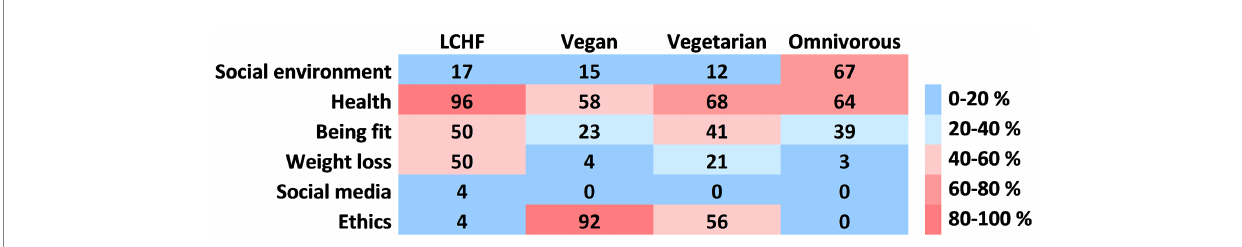
FIGURE 2 Motives for choosing the current dietary pattern. More than one motive could have been chosen by each participant. Results are shown as percentage of each